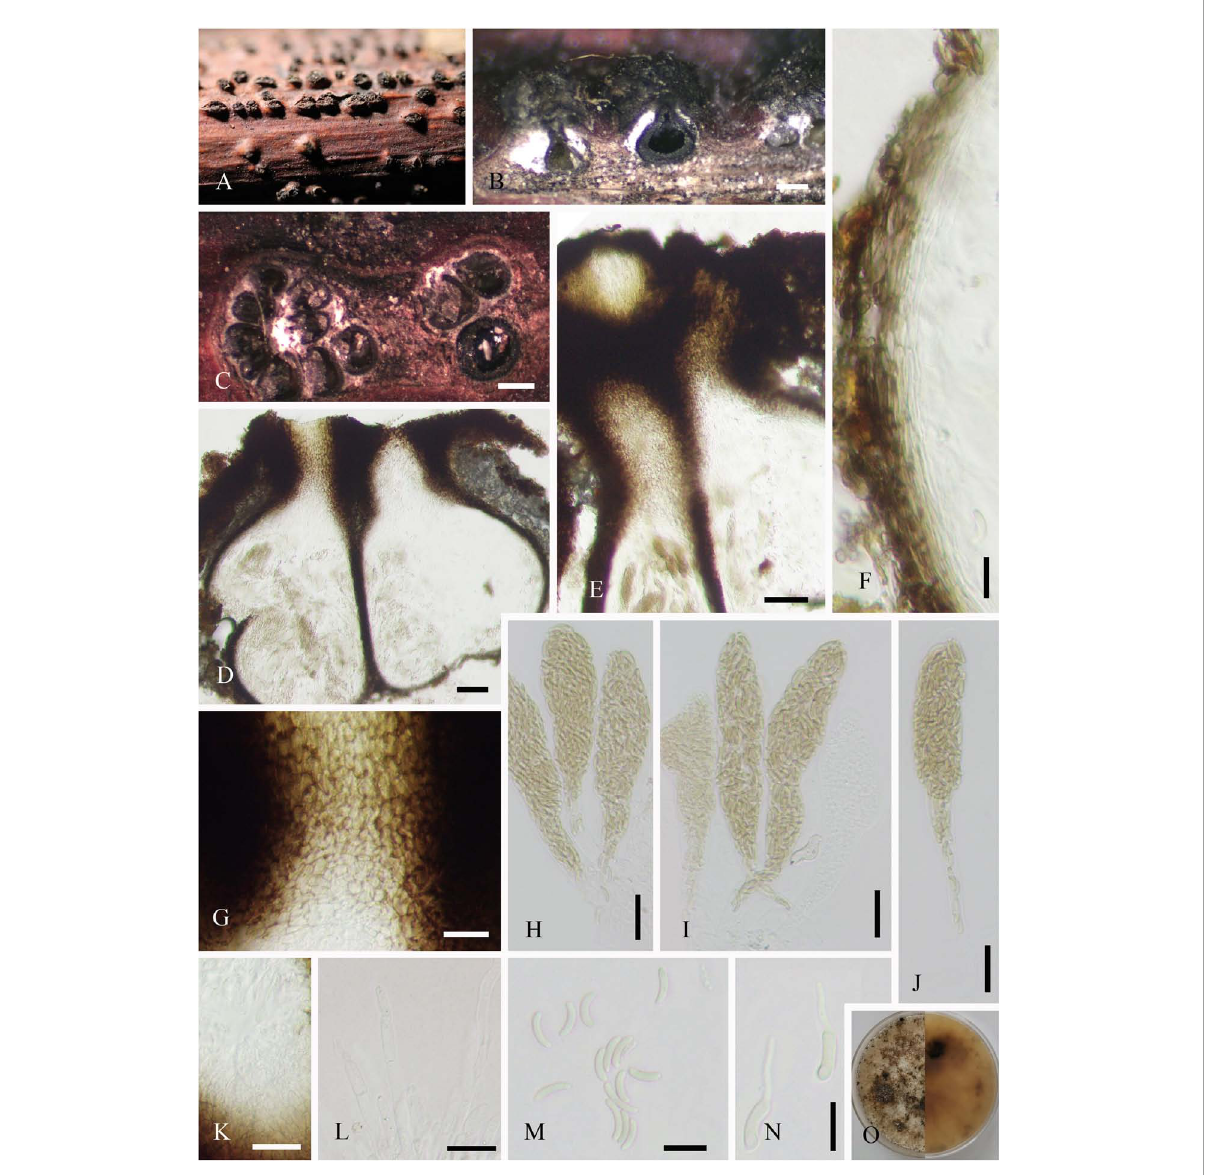
FIGURE2 Diatrypella vulgaris (SICAU 22-0101). (A) Stromata on host substrate. (B) Vertical section through stromata. (C) Transverse sections through stromata. (D) Section through the locules. (E,G,K) Ostiolar canal. (F) Peridium. (H–J) Asci. (L) Paraphyses. (M) Ascospores. (N) Germinating ascospores. (O) Colony on PDA for 15 days. Scale bars: (B,C) 200 um, (D,E) 50 um, (F) 10 um, (G–L) 20 um, and (M,N) 10 um.